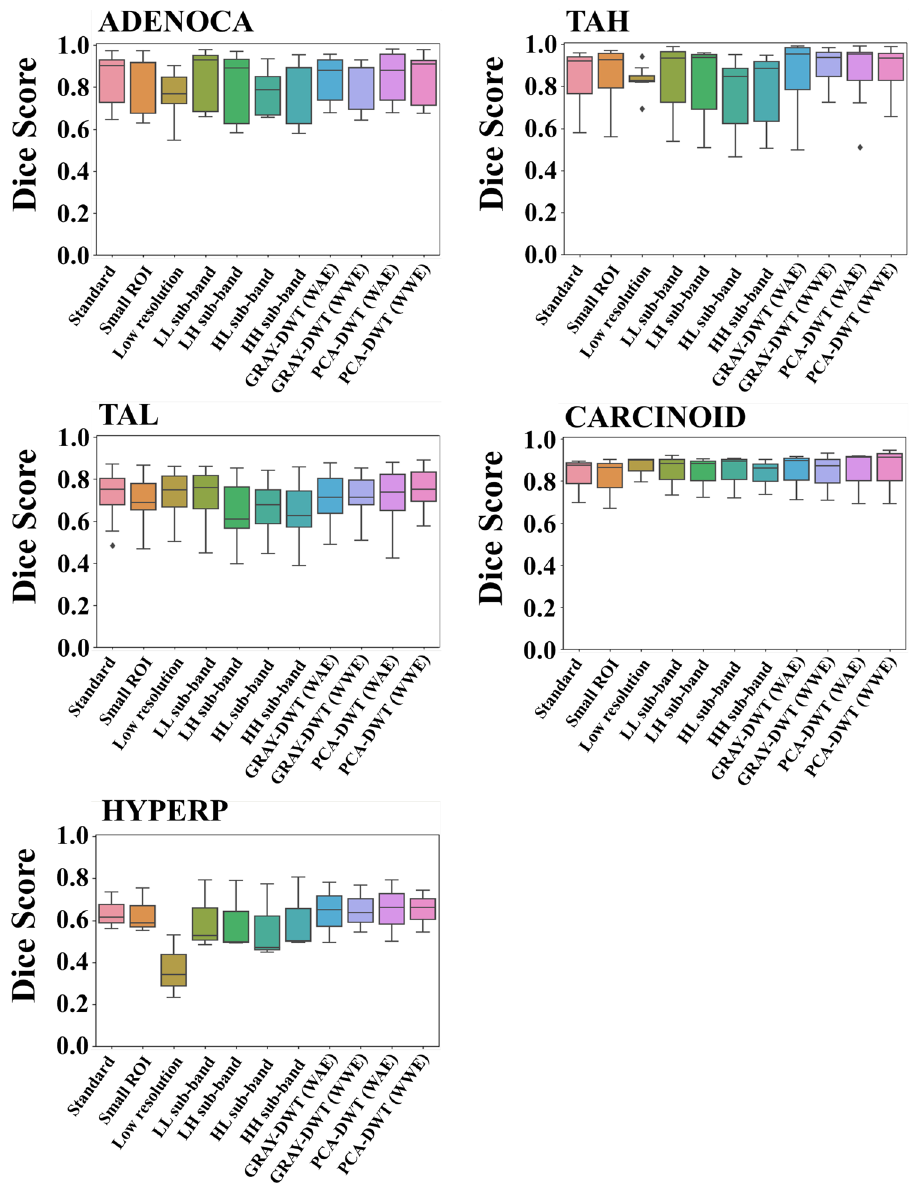
Figure 1. Comparison of Dice for each class between the result of standard input in spatial domain (Tile size: 512 by 512, ×20 magnification, standard), the result of small ROI input in spatial domain (Tile size: 256 by 256, ×20 magnification, Small ROI), the result of low resolution input in spatial domain (Tile size: 512 by 512, ×10 magnification, low resolution), the result of weighted average ensemble (WAE) result for wavelet sub- band after grayscale conversion (GRAY-DWT (WAE)), the result of wavelet weighted ensemble (WWE) result for wavelet sub-band after grayscale conversion (GRAY-DWT (WWE)), the result of weighted average ensemble (WAE) result for wavelet sub-band after principle component analysis (PCA) (PCA-DWT (WAE)), and the result of wavelet weighted ensemble (WWE) result for wavelet sub-band after principal component analysis (PCA) (PCA-DWT